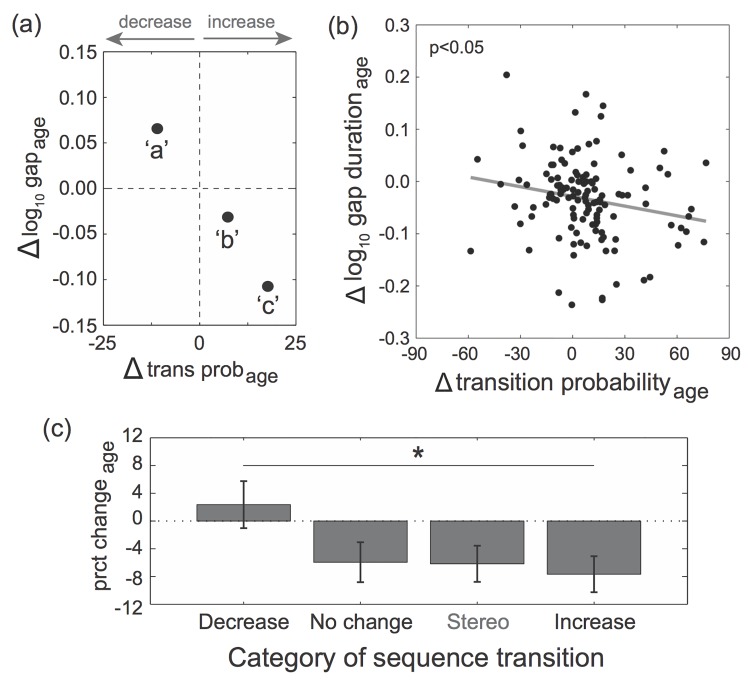
Relationship between age-dependent changes to transitions probabilities and gap durations within branch points.(a). An example of age-dependent changes to gap durations as a function of age-dependent changes to transition probabilities. Gap durations decreased for the two transitions that increased in prevalence whereas the duration of the gap for the transition that became less prevalent over time increased. (b). There was a significant negative relationship between age-dependent changes to transition probabilities and log10 gap durations (F1,108.4 = 5.3, p = 0.0230; slope = -0.063±0.027). (c). The magnitude of change (percent change) in gap durations varied depending on whether the prevalence of a transition within a branch point significantly decreased, did not significantly change, or significantly increased (Likelihood ratio test) over time. Also included in the analysis was the percent change in gap durations for transitions within stereotyped sequences (data from [34]). The magnitude of change in gap durations was significantly different between transitions that significantly decreased and transitions that significantly increased in transition probability over time (Tukey’s HSD, p<0.05) and nearly identical between stereotyped transitions and branch point transitions that did not change in probability over time.